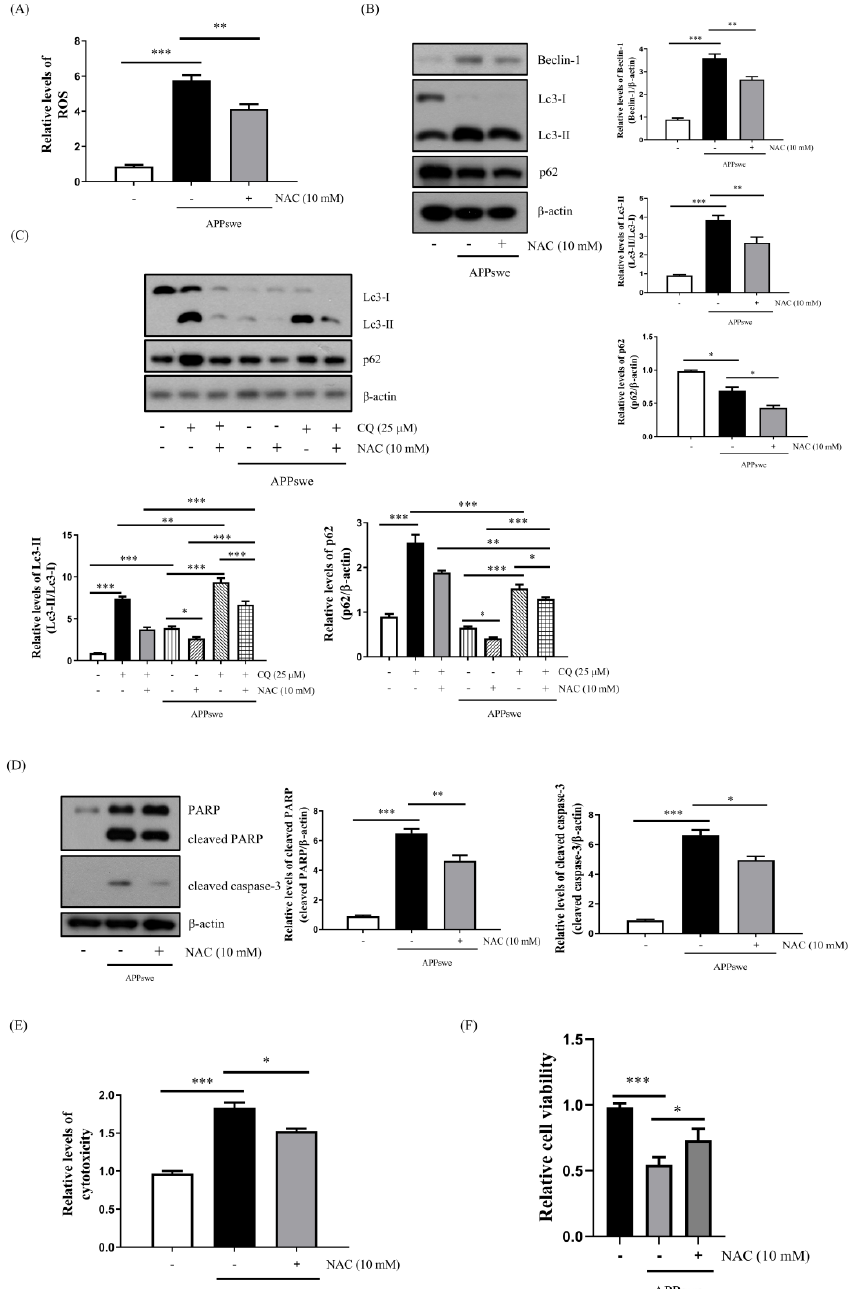
Figure 3. Autophagy, cytotoxicity, and cell death were increased by A β O-mediated oxidative stress in N2a-APPswe cells. ( A ) Intracellular ROS levels were determined using flow cytometry in N2a and N2a-APPswe cells cultured for 24 h and treated with N-acetylcysteine (NAC) (10 mM) for 24 h. ( B ) Western blot analysis of Beclin-1, Lc3, and p62 proteins from N2a and N2a-APPswe cells cultured for 24 h and treated with NAC (10 mM) for 24 h. ( C ) Lc3 and p62 protein expression was determined by Western blot analysis using N2a and N2a-APPswe cells cultured for 24 h with or without CQ (25 μM) and/or NAC (10 mM) for 24 h. ( D ) PARP and cleaved caspase-3 protein levels were analyzed by Western blot analysis in N2a and N2a-APPswe cells cultured for 24 h with NAC (10 mM). ( E ) LDH analysis of cytotoxicity in N2a and N2a-APPswe cells cultured for 24 h with NAC (10 mM). ( F ) Cell viability was measured using a CCK cell viability assay kit for N2a and N2a-APPswe cells cultured for 24 h and treated with NAC (10 mM) for 24 h. Data are represented as the means ± SEMs of three independent experiments (* p < 0.05, ** p < 0.01, and *** p <